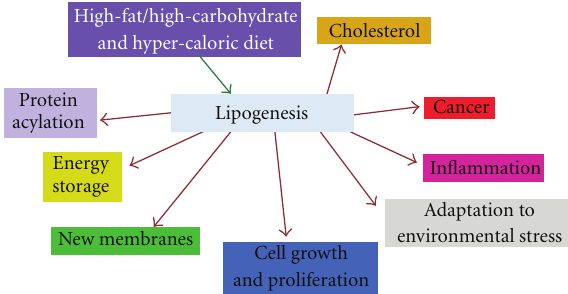
Figure 5: Metabolic patterns and diseases correlated with lipogen-